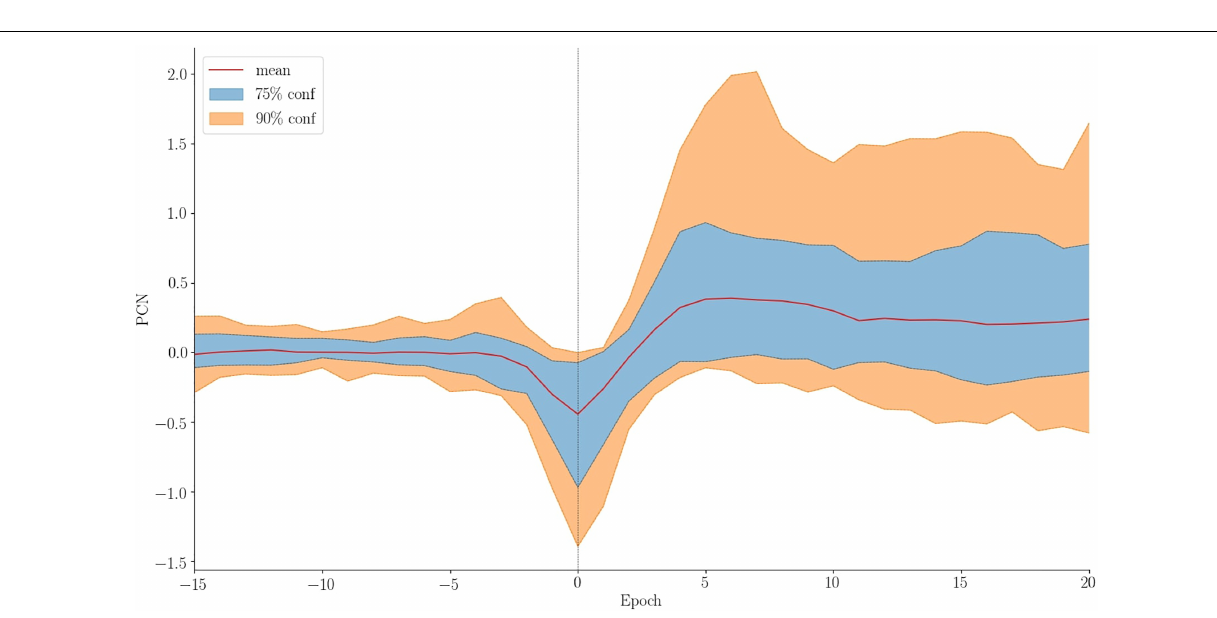
FIGURE 10 | Superposed epoch analysis of the high latitude response to rapid increases in P d during Northward IMF and negative dipole tilt using the PCN index. The analysis is based on 90 events each of which were aligned with respect to the peak of the PI and shifted to a common baseline to improve comparison. The red line shows the mean and the blue and orange shade indicates the 75 and 90% confidence